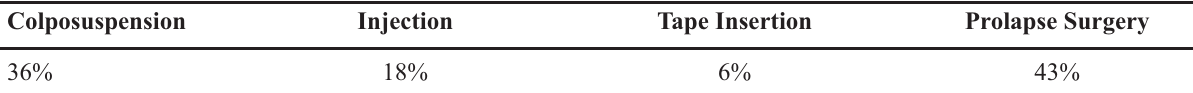
Table 2 – Prior operations in the patients with recurrent urinary incontinence.